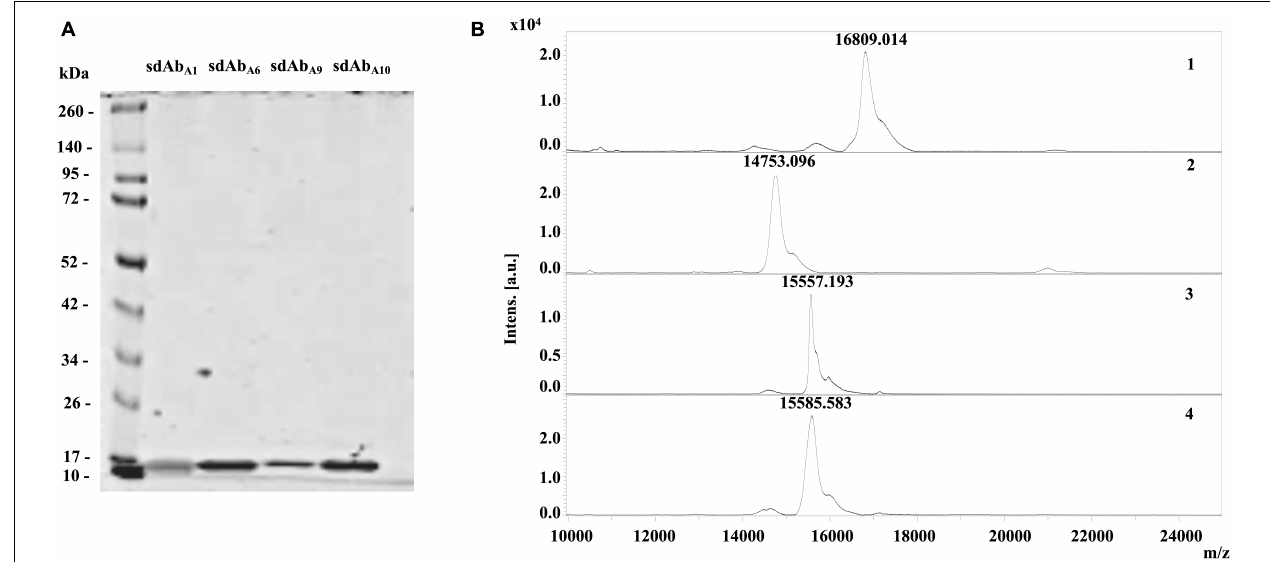
FIGURE 4 | Quality assessment and amino acid sequence of overexpressed sdAbs. (A) Overexpressed and Nickel Nitrilotriacetic Acid (Ni NTA) purified sdAbs, sdAb A1 , sdAb A6 , sdAb A9 , and sdAb A10 , subjected to LDS-PAGE showed prominent protein band at ∼ 15 kDa. (B) Protein mass spectrum of sdAb A1 (1), sdAb A6 (2) sdAb A9 (3), and sdAb A10 (4) showing single peak on MALDI TOF MS are presented with the corresponding molecular mass of